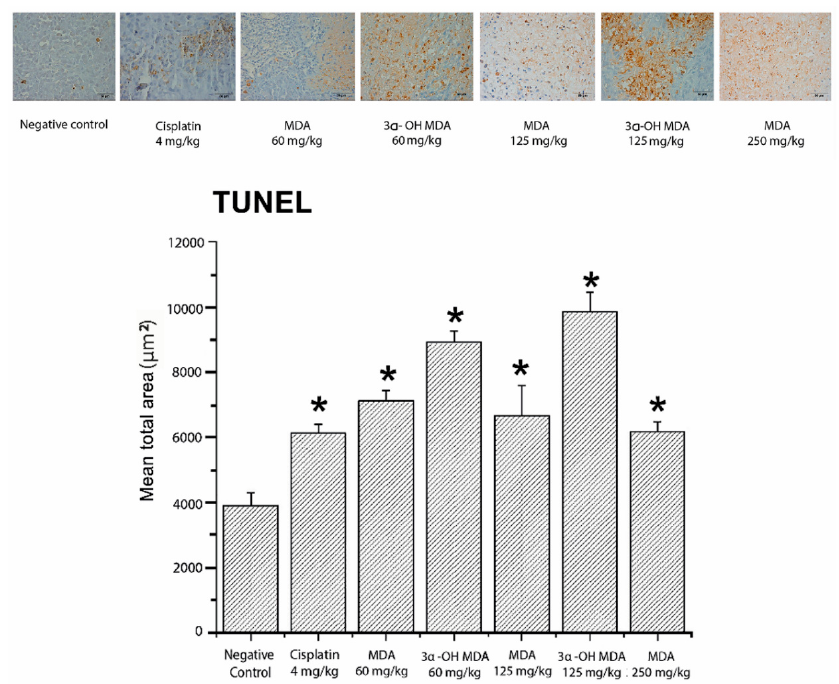
Figure 6. Terminal deoxynucleotidyl transferase dUTP nick end labeling (TUNEL) analysis for the detection of apoptosis in the tumor samples. The values across the histogram represent the result of quantitative analysis of marked areas using Image-Pro Plus 7.0 software (Media Cybernetics). The data are shown as the means ± SEM of three xenografts analyzed for each group. * p < 0.05, significant differences compared with the control.